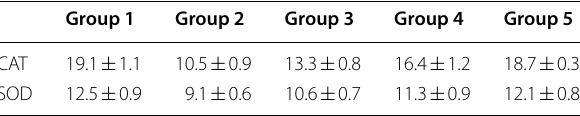
Mean standard deviation; n ±